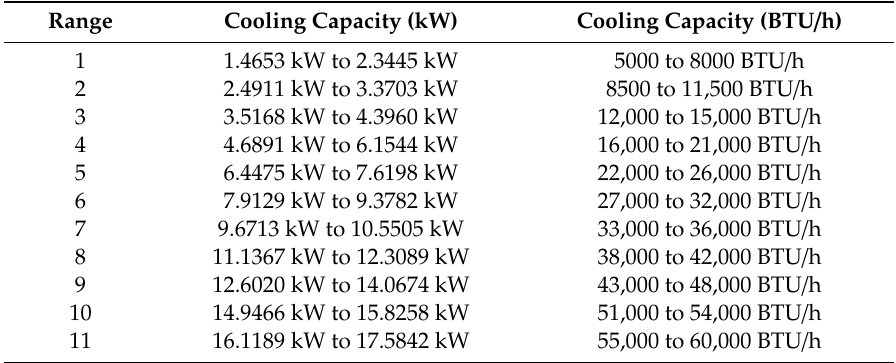
Figure 3. Chromosome developed to address the problem. Table 2. Cooling capacity value ranges defined in the methodology. Table 2. Cooling capacity value ranges defined in the methodology.